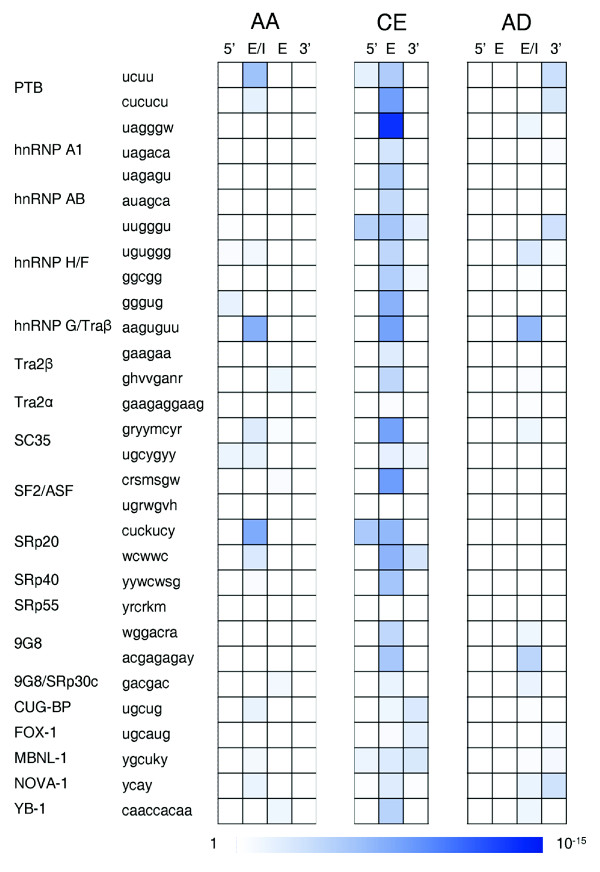
Enrichment of SFBSs in alternative exons. A heat map representing the -log10(P-value) of a series of Wilcoxon tests, comparing the normalized density of SFBS predictions in cassette exons (CE), alternative acceptors (AA), and alternative donors (AD) to a background of constitutive exons. The tests were carried out for the full exonic sequences (E), for 100-nucleotide intronic sequences (5' and 3') flanking the alternative exon and for extended regions 'exons and/or introns' (E/I). The P-values were corrected with the Westfall-Young procedure.